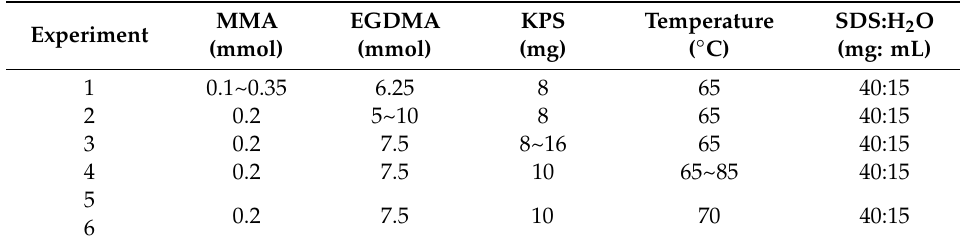
Table 1. Synthesis information of solanesol molecularly imprinted polymers (SSO-MIPs). EGDMA: ethylene glycol dimethacrylate, MMA: methyl methacrylate, KPS: potassium persulfate, SDS: sodium dodecyl